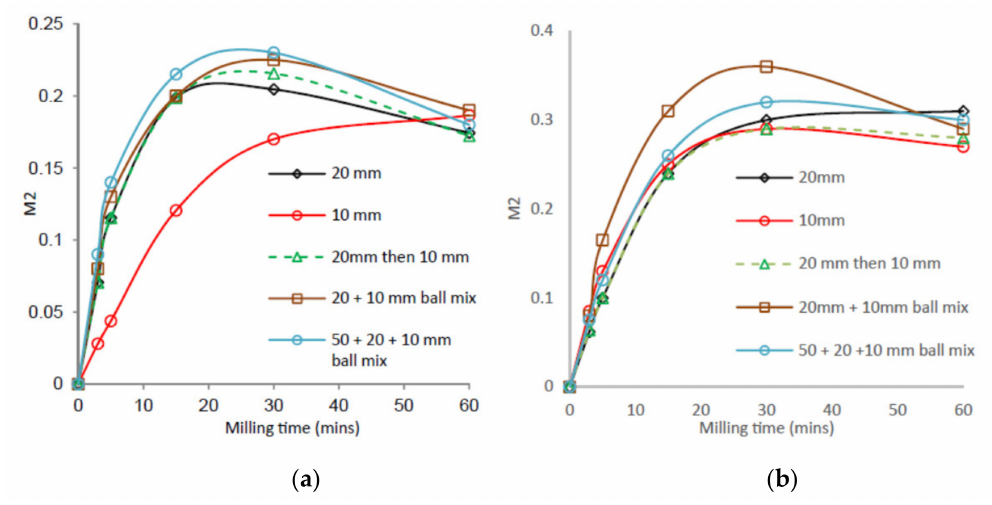
Figure 10. Mass fraction m 2 vs. milling time for various ball sizes ( a ) feed size = − 1700 + 850 µ m